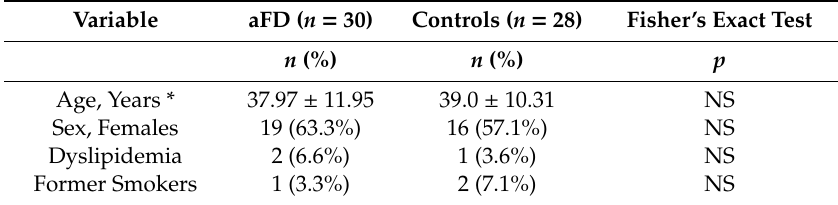
Table 1. Clinical and demographic features of participants.